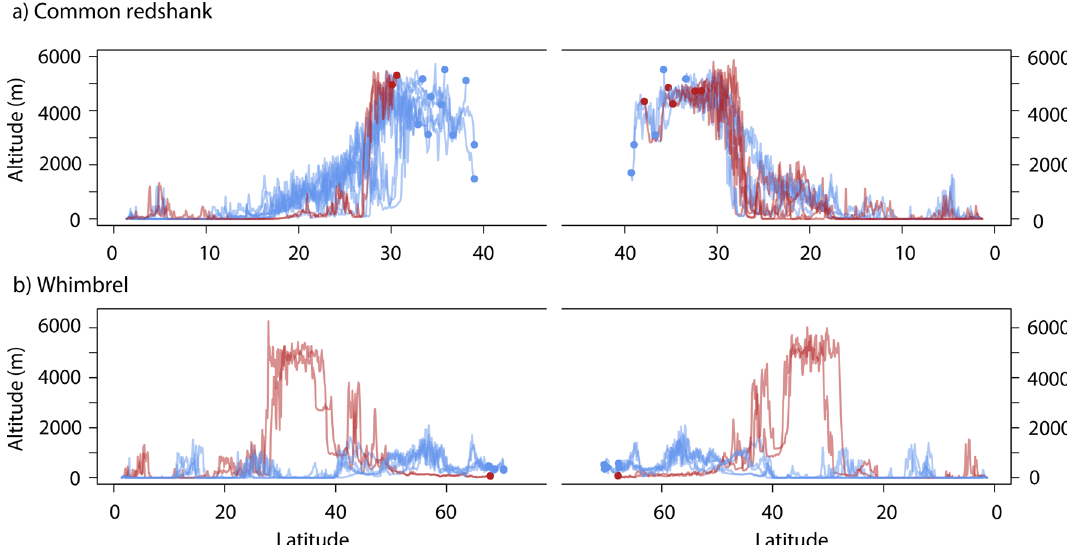
Figure 4. Latitude and altitude of northward and southward migration of adult Common Redshanks (n = 13, based on light-level geolocation and PTT satellite transmitters attached to birds in Singapore, 2015–2019) and adult Whimbrels (n = 8, based on PTT satellite transmitters attached to birds in Singapore in 2018 and 2019). Red lines indicate a trans-Himalayan route; blue lines indicate birds that migrated east of the Himalayan range (Common Redshanks) or through the East Asian-Australasian Flyway (Whimbrels).